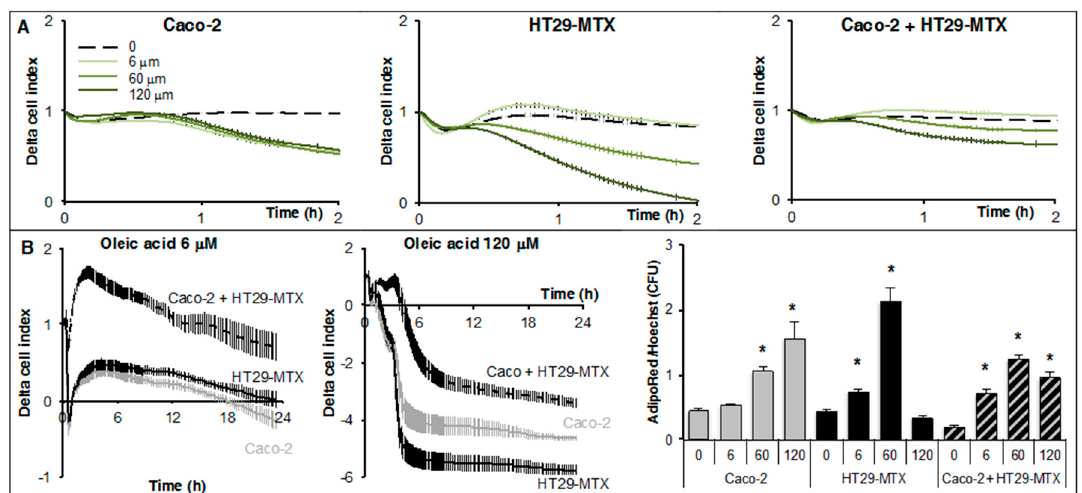
Figure 5. Real-time monitoring of lipid uptake by Caco-2, HT29-MTX cells, and in co-cultures (9/1). Real-time cell analyses (RTCA) were performed on fully differentiated cells (Day 18) treated with several doses of oleic acid complexed to bovine serum albumin. These are representative experiments presented as mean values ± SEM ( n = 8 wells) with significant Student t -test p -values <0.05) represented by stars. ( A ) xCELLigence analysis of delta cell index (cell indexes normalized at time of treatment) on a short term experiment (2.5 h) in presence of increasing concentrations of oleic acid; ( B ) Comparative analysis on xCELLigence of cells treated by oleic acid 6 (left panel) or 120 μ M (central panel) for 24 h then fixed for triglyceride storage measurement (AdipoRed intensity) normalized to nuclei counts (Hoechst counts) on Cytation 3 plateform (right panel). Cell indexes were measured every 2 min for 1.5 h then every 15 min.